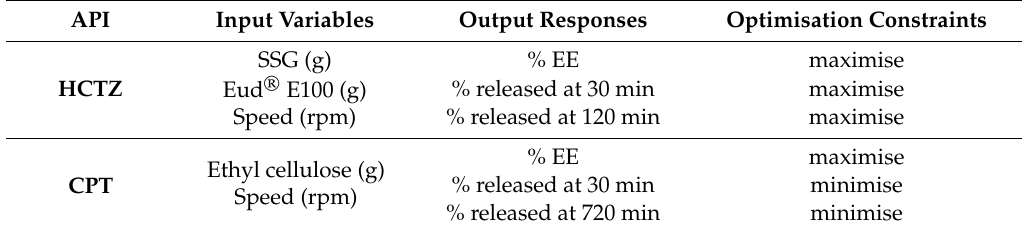
Table 1. Input variables for the experimental design, outputs monitored and optimisation